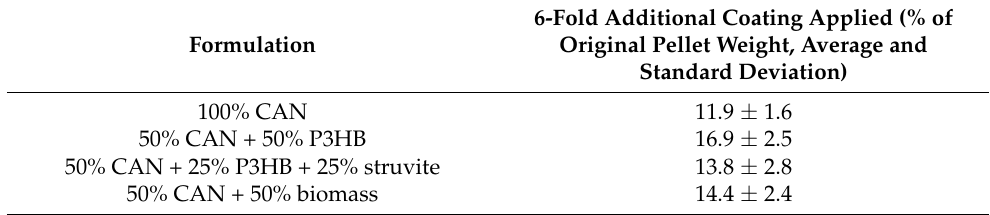
Table 5. Calculated average weight (%, n = 10) and standard deviation of manually applied 6-fold coating for all pellet formulations prepared on a hydraulic